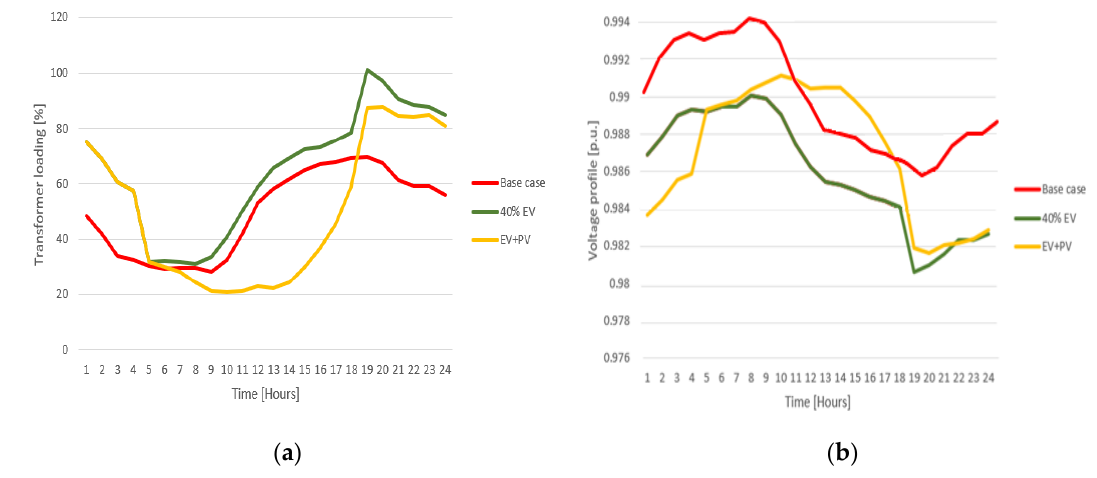
Figure 14. Comparison of rural ( a ) transformer loadings and ( b ) most loaded feeder voltage profiles with 40% EV penetration.